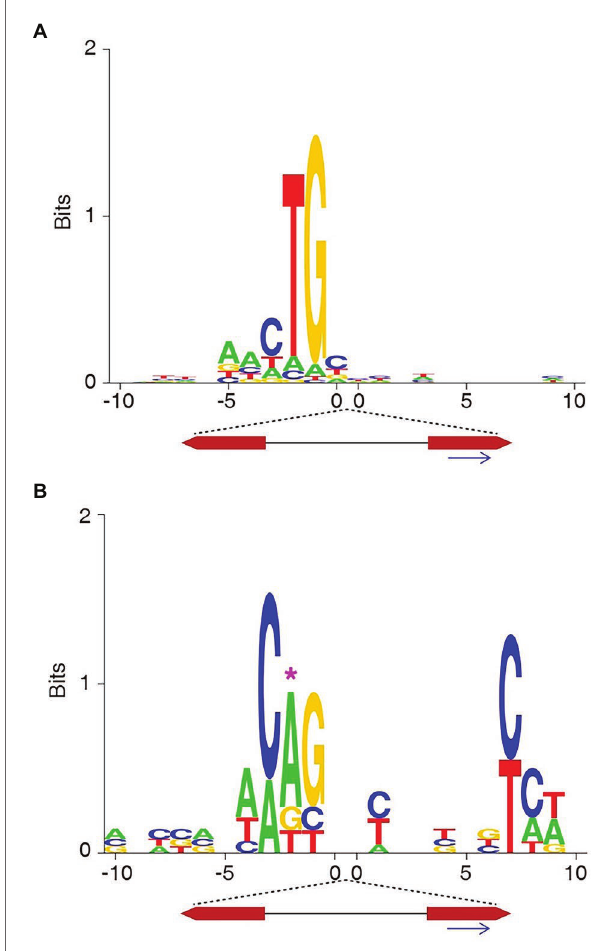
FIGURE 3 | The target site consensus sequences of the non-TA integrations of the transposons with native or mutated IR/DR ends. (A) The consensus sequences of non-TA target sites of pYT22 sequenced from the left side (native end). (B) The consensus sequences of non-TA target sites of pYT53 sequenced from the left side. The position corresponding to the mutations was labeled with pink